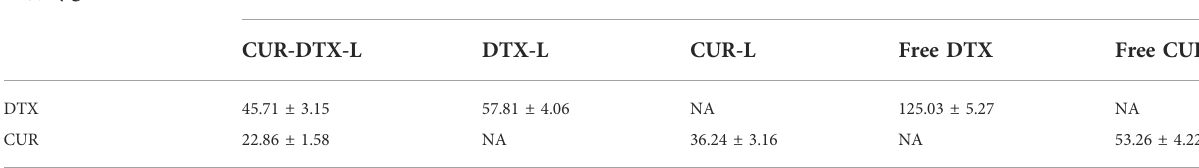
TABLE 4 IC 50 values of formulations and free drugs in MCF-7 cells measured by the CCK-8 assay ( n = 3). IC 50 ( μ g/ml)